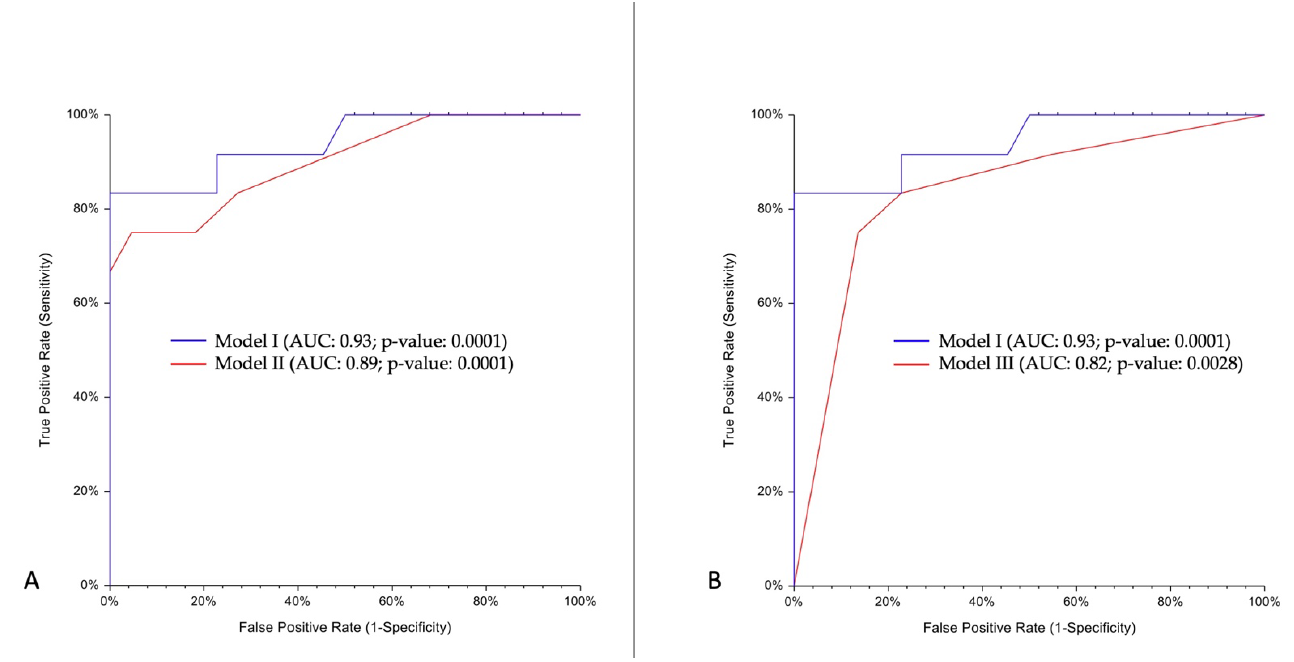
Figure 2. Non-inferiority test for two AUCs. Model I (symptoms, multivessel diseases, ischemia, and strain anomalies); Model II (ischemia and strain anomalies); Model III (symptoms and multivessel diseases). Panel ( A ) shows comparison between Model I (blue line) and II (red line) AUCs. In panel ( B ), comparison between Model I (blue line) and Model III (red line) AUCs. AUC: area under